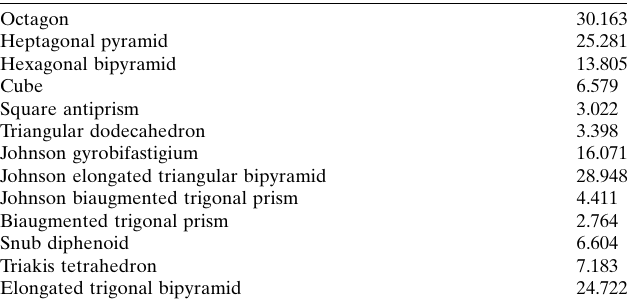
Table 6 Continuous shape measurement (CShM) values ( SHAPE 2.1 ) for the eight-coordinate sodium ion of 2 .